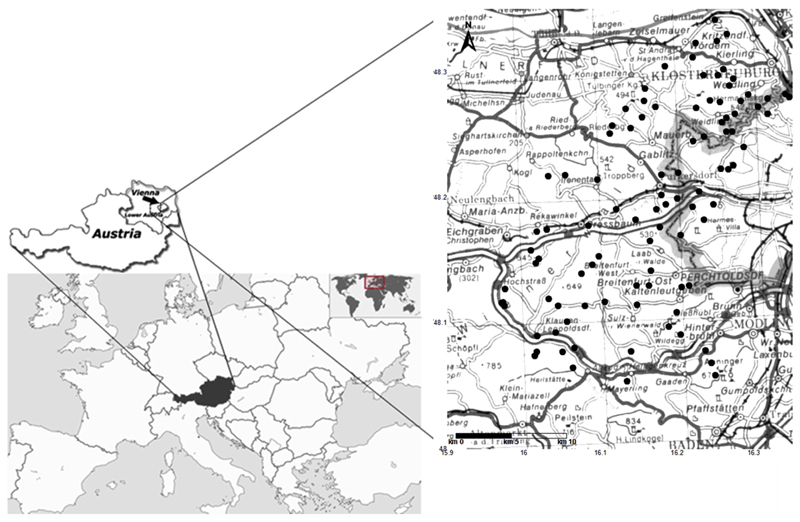
Location of 97 study sites in the Vienna Woods in 2012.